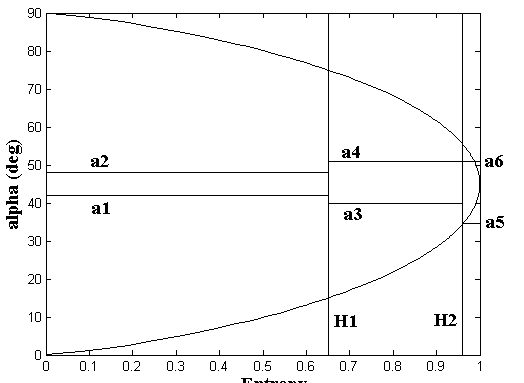
Fig.3. Names of H - α boundaries for classification of different PSMs.